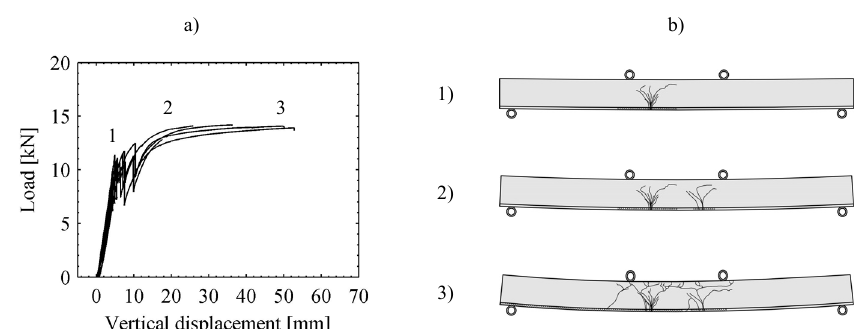
Figure 4: a) Load-displacement diagrams and b) cracking sequence of the experiments.